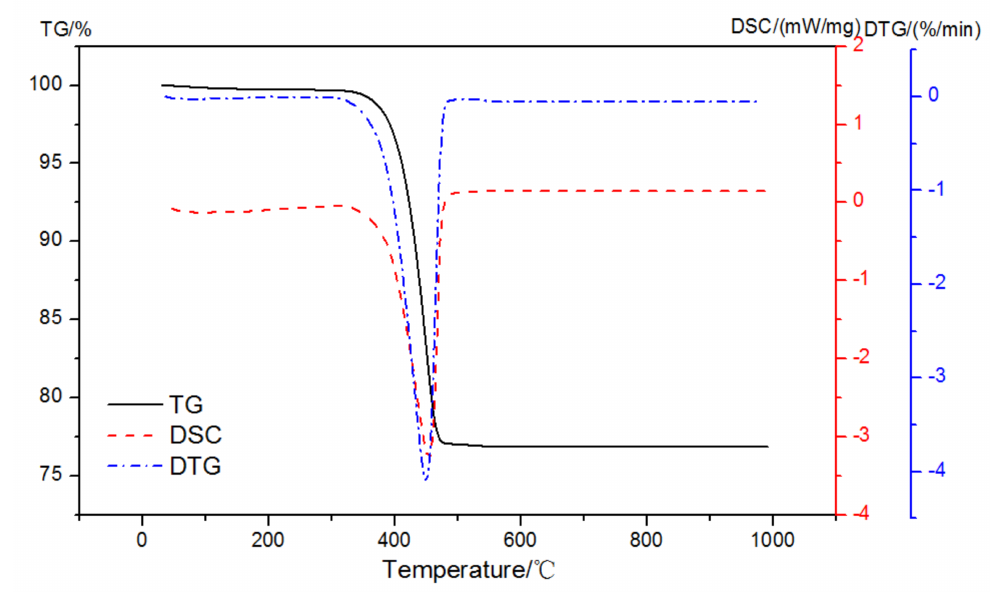
Figure 4. TG-DSC-DTG curves of analytically pure CH in a pure N 2 gas dynamic atmosphere.